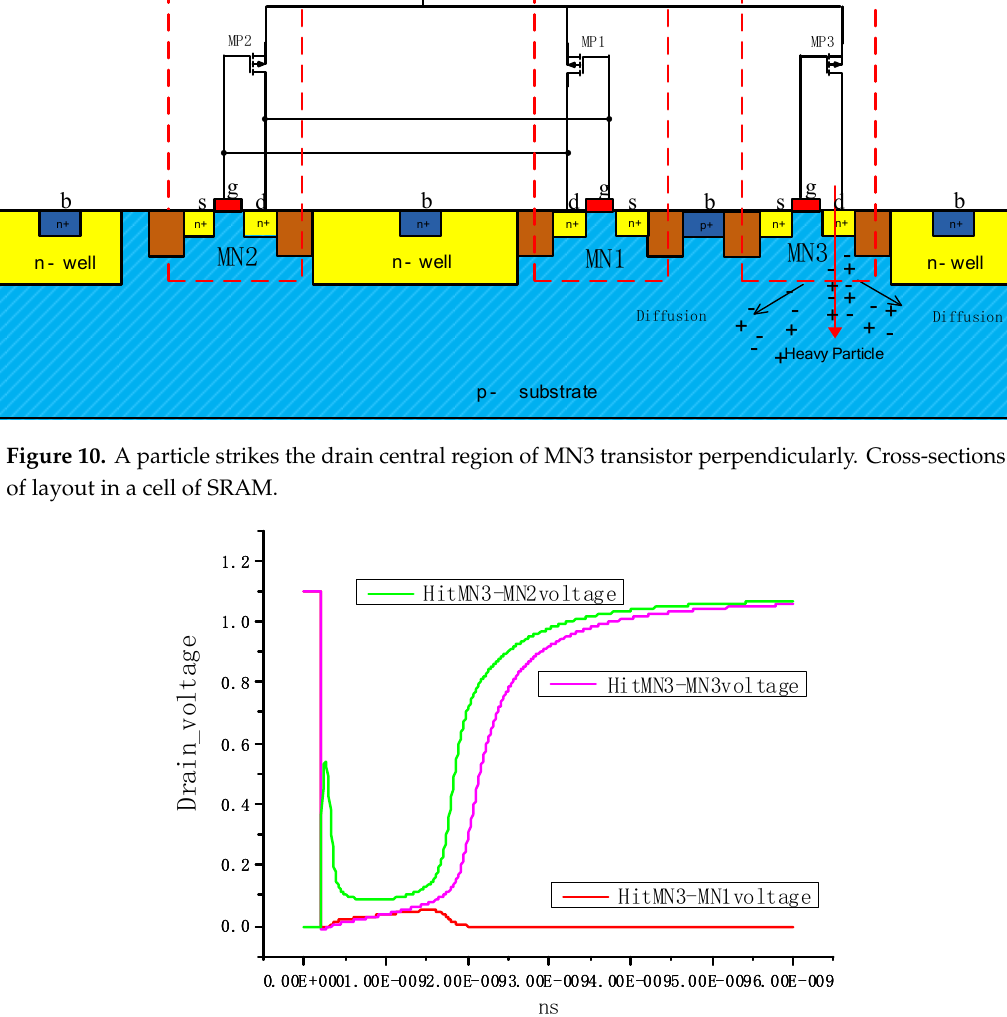
Figure 11. Drain voltage in MN1, MN2, and MN3 transistors when the drain central region of nMOS transistor MN2 is struck by a particle.